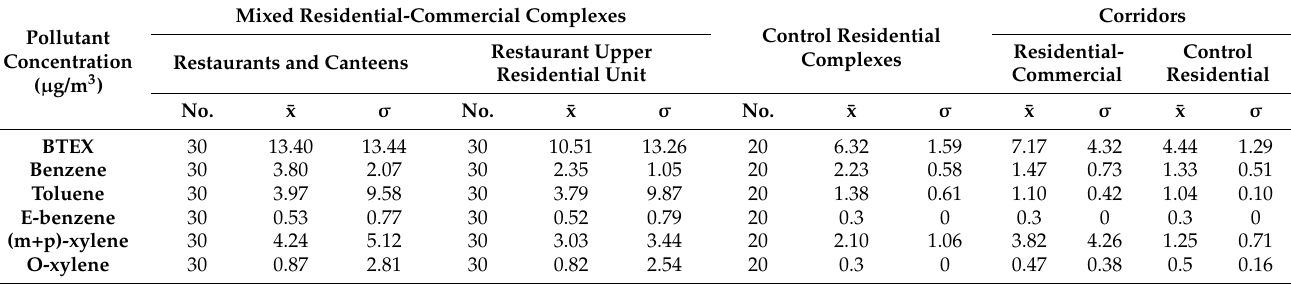
Table 2. The mean and standard deviation for the studied